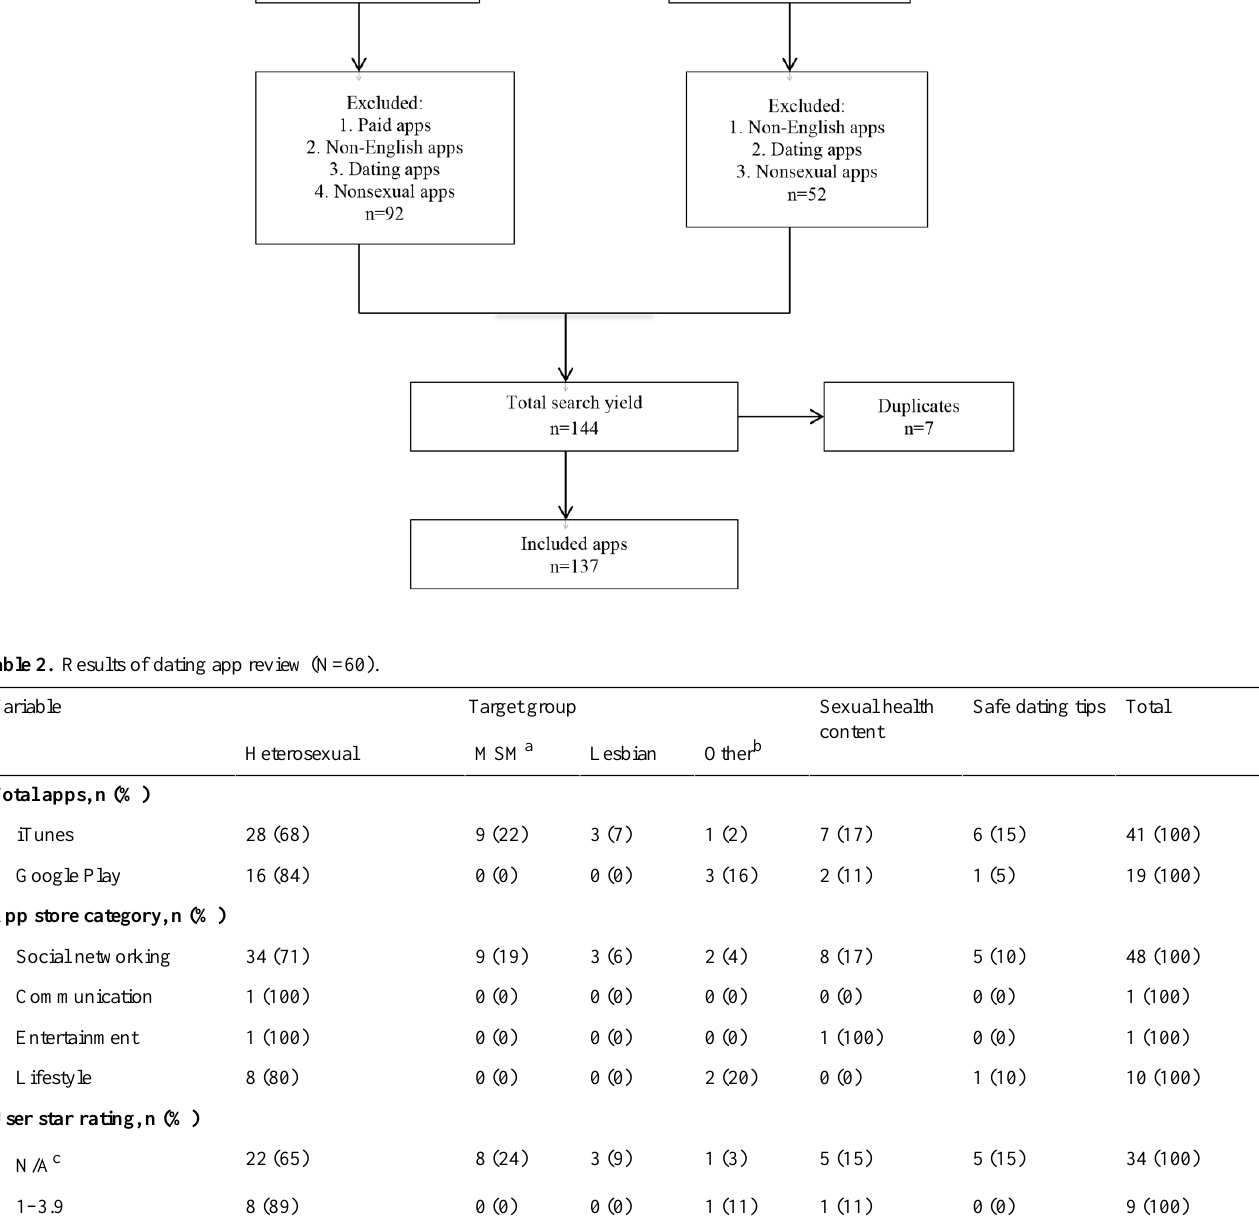
Figure 1. Inclusion of sex-related apps.